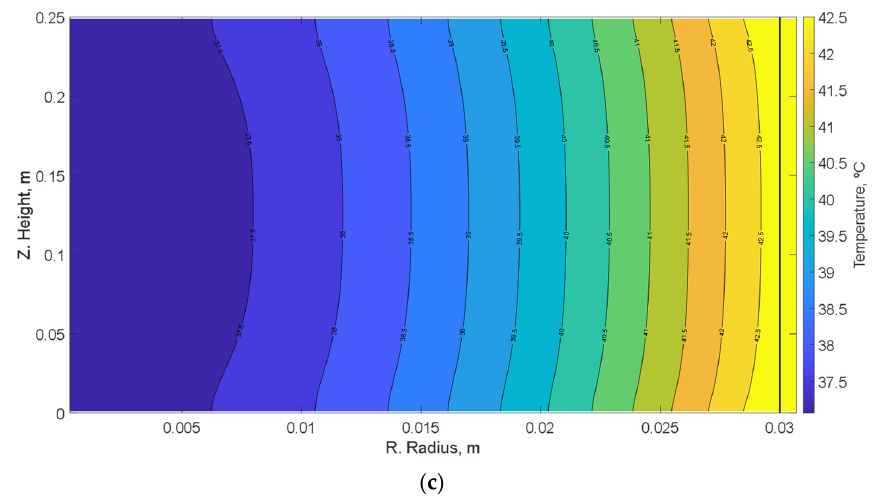
Figure 13. Distribution of temperatures for each of the materials at one hour and an ambient temperature of 50 ◦ C. ( a ) Al319, ( b ) PET, and ( c )